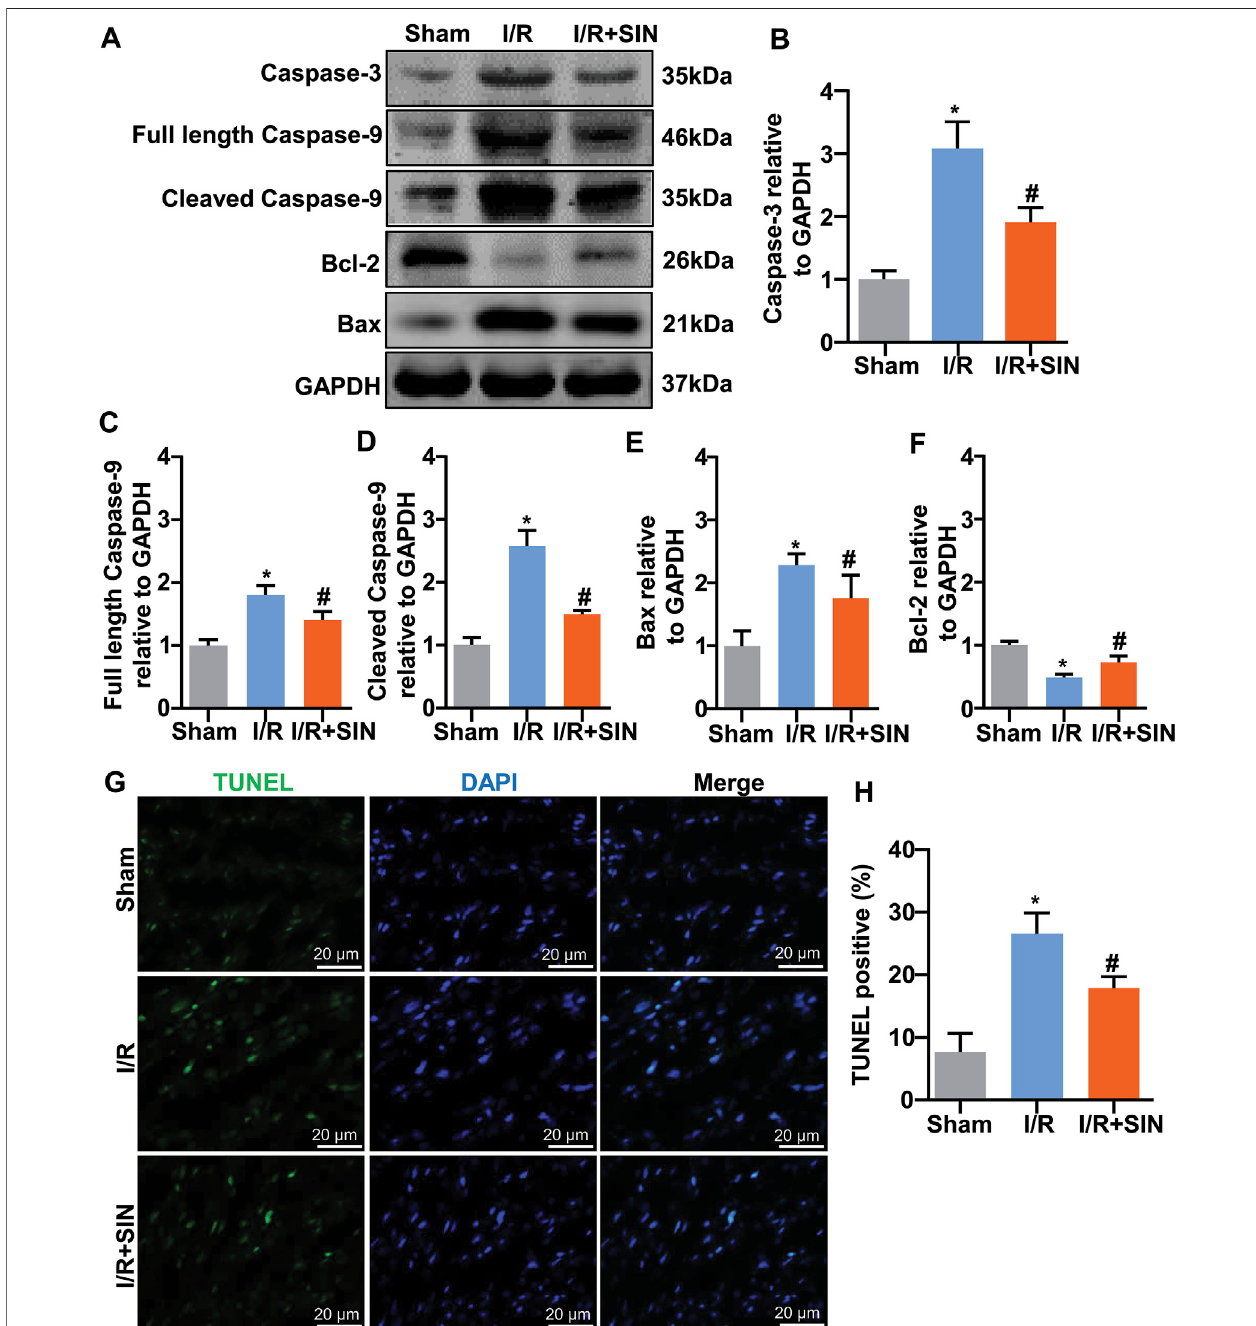
FIGURE 3 | Effect of SIN on myocardial apoptosis induced by MIRI. (A ‒ F) Representative images and quantitative analysis show that pretreatment with SIN prevented the MIRI-induced increase in expression levels of caspase-3 (A,B) , full-length caspase-9 (A,C) , cleaved caspase-9 (A,D) , and Bax (A,E) in ischemic heart tissue and the MIRI-induced decrease in expression levels of Bcl-2 (A,F) ( n = 5, * p < 0.05 vs. sham, # p < 0.05 vs. I/R). (G,H) Representative images (G) and quantitative analysis (H) show that pretreatment with SIN prevented the MIRI-induced increase in the number of TUNEL-positive cells in ischemic heart tissue ( n = 5, * p < 0.05 vs. sham, # p < 0.05 vs. I/R). Data are shown as means ± SEM.